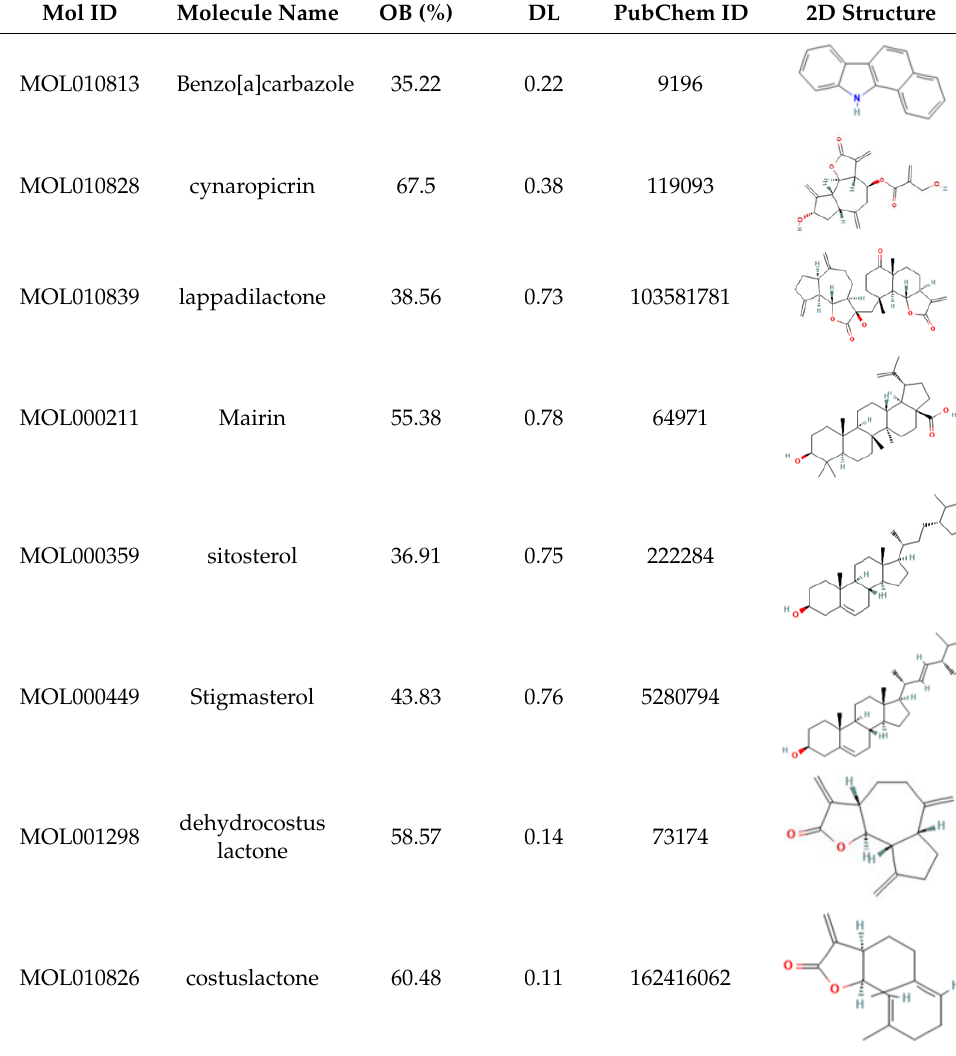
Table 2. Potential active ingredients of Aucklandiae Radix (AR).